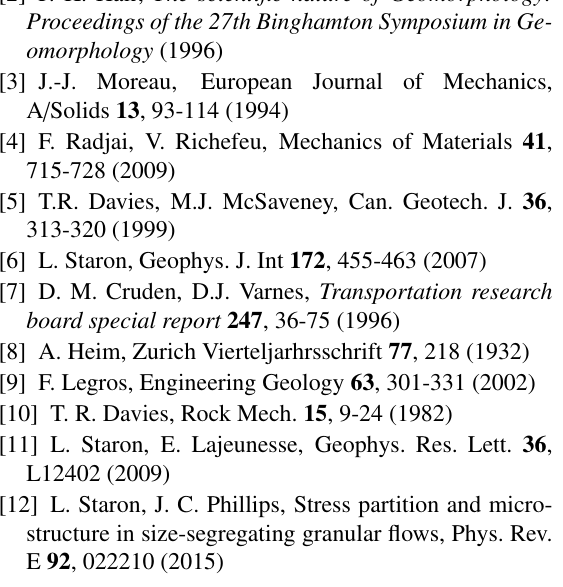
Figure 6. Coe  cient of friction computed from the stress tensors in the neighbourhood of the gravity centre G and the secondary upstream and downstream ones G 0 and G 00 as a function of the volume V involved during the flow.